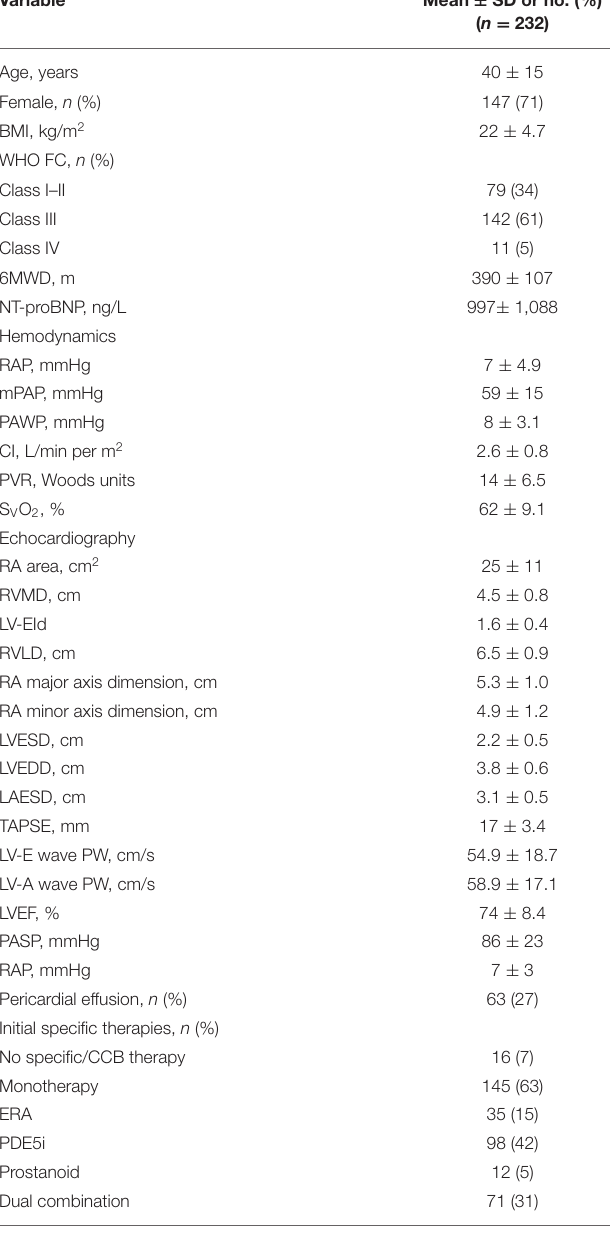
TABLE 1 | Baseline clinical, hemodynamic, and echocardiographic characteristics of patients with IPAH.